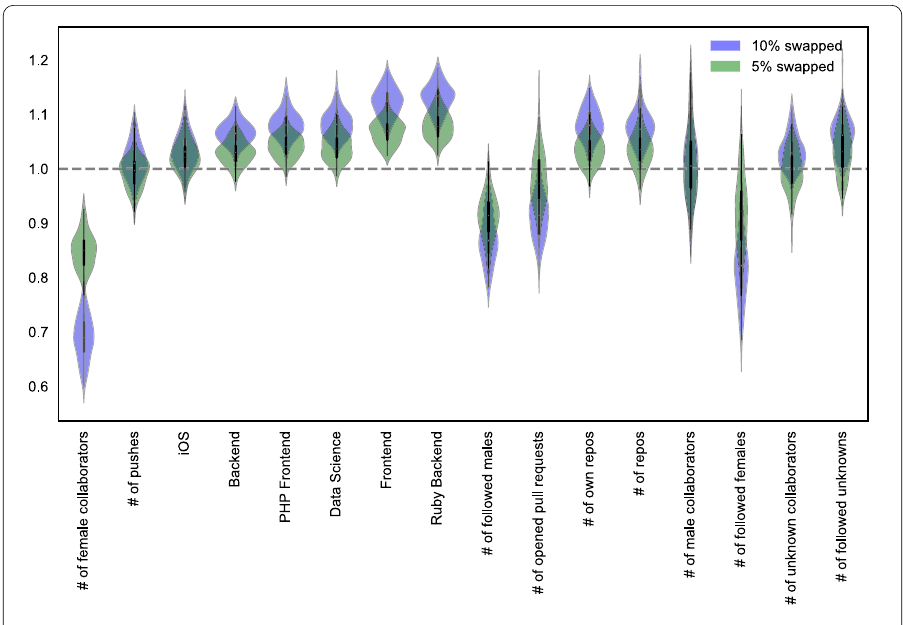
Figure 6 Relative variable importance after randomization, normalized by original importance ( n = 100). Random Forest prediction with 100 datasets where 5% gender swapped AUC’s mean is 0.672 (SE:0.002), and 10% mean: 0.651 (SE:0.003). Variables indicate female-gender homophily, number of female collaborators and the number of followed females and males are the most sensitive to gender